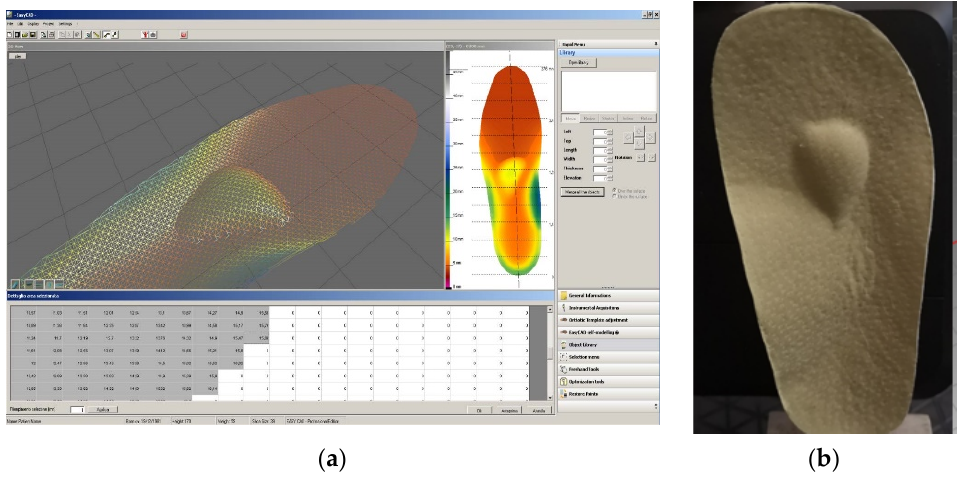
Figure 2. Insole: ( a ) CAD design of the insole; ( b ) Insole with arch